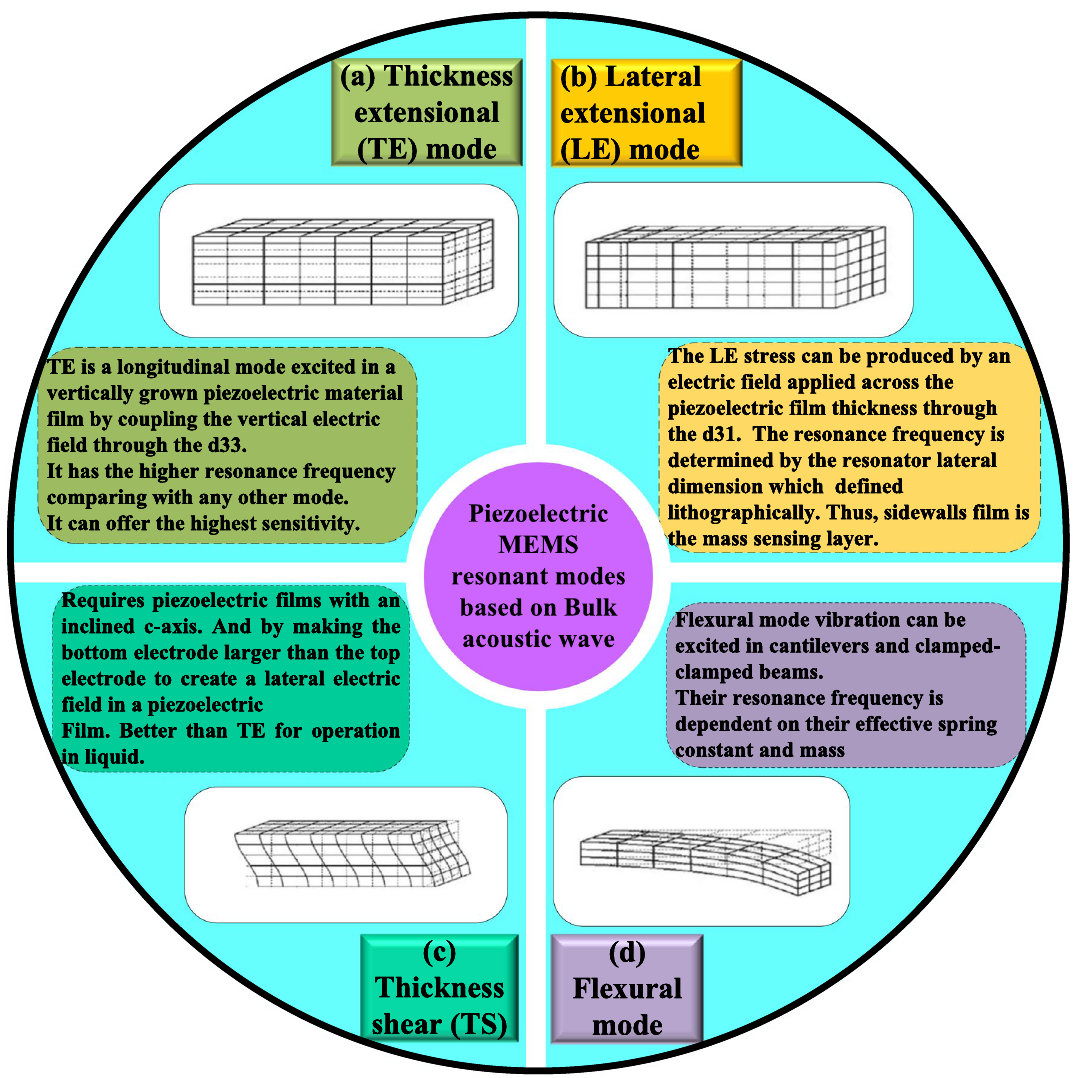
Fig. 4 Typical piezoelectric vibration modes based on bulk acoustic waves, ( a ) thickness extensional (TE) mode, ( b ) Lateral extensional (LE) mode, ( c ) Thickness shear (TS), and ( d ) flexural mode [119, 136,